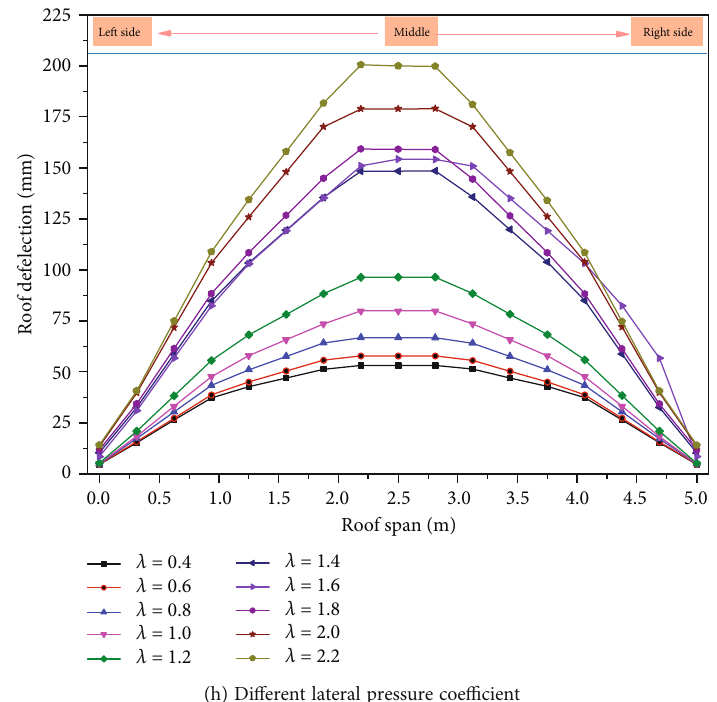
Figure 4: Roof subsidence of compound roof coal roadway under di ff erent in fl uencing